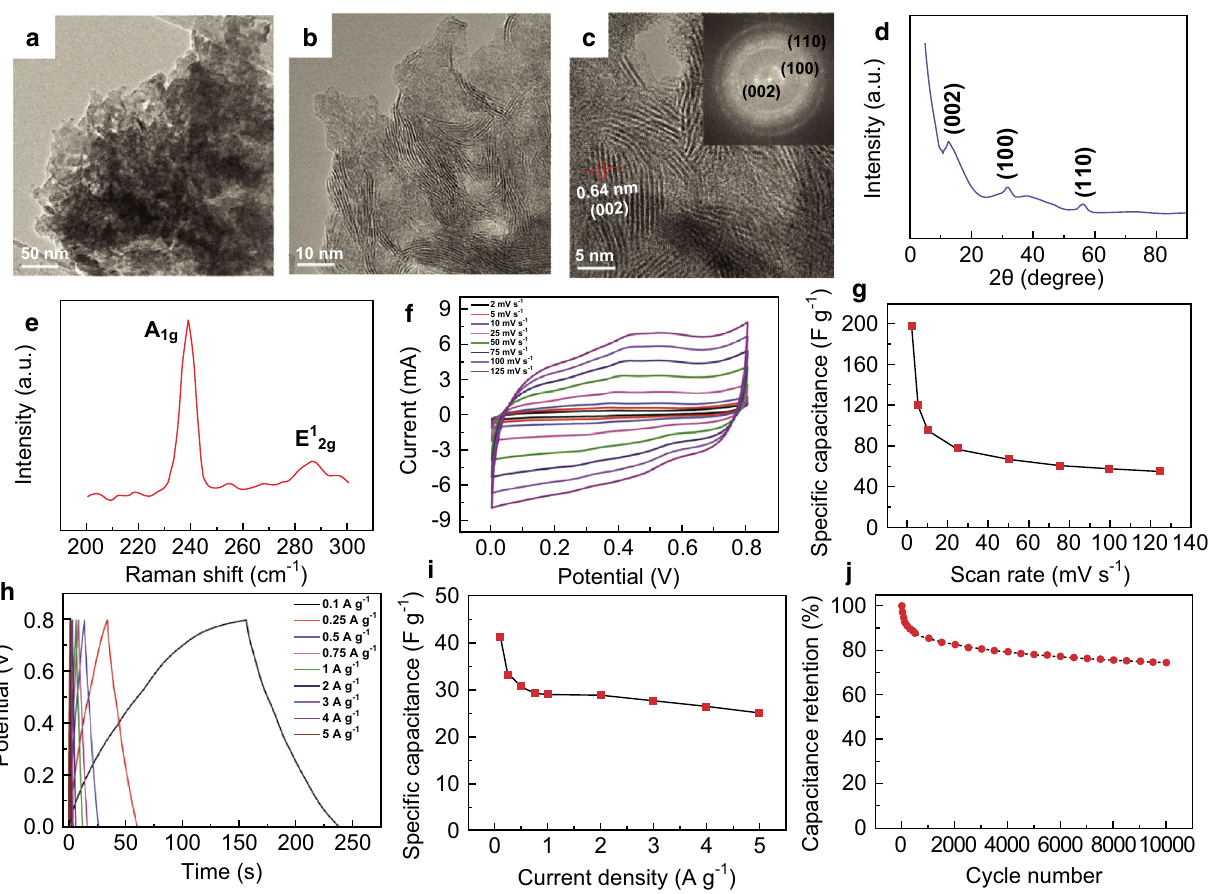
Fig. 6 Structural characterization and electrochemical performance analysis of TMD (MoSe 2 ) as a supercapacitor electrode: a , b TEM images of MoSe 2 nanosheets at low magnification. c HRTEM image of the MoSe 2 sheets with the FFT pattern demonstrated in the inset. d XRD spectra of the few-layered MoSe 2 nanosheets showing the characteristic peaks. e Characteristic Raman spectra of the few-layered MoSe 2 nanosheets where the A 1g and E 1 vibration modes are clearly visible. f CV of the few-layered MoSe 2 sample in 0.5 M H 2 SO 4 with scan rates varying from 2 to 2g 125 mV s - 1 . g Corresponding specific capacitance values at the given scan rates. h First-cycle GCD curves at different current rates, of the few- layered MoSe 2 sample. i Specific capacitance values for the corresponding current rates. j Specific capacitance retention of the few-layered MoSe 2 sample, being run for 10,000 cycles at a current rate of 5 A g - 1 in 0.5 M H 2 SO 4 electrolyte [129]. Copyright 2015 Royal Society of Chemistry Table 3 Performance of layered 2D TMD electrodes in various non-Li supercapacitor